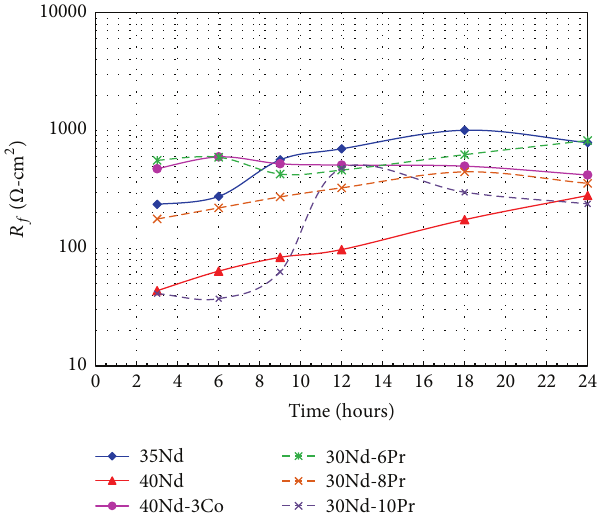
Figure 19: 𝑅 𝑓 variation against time for the tested